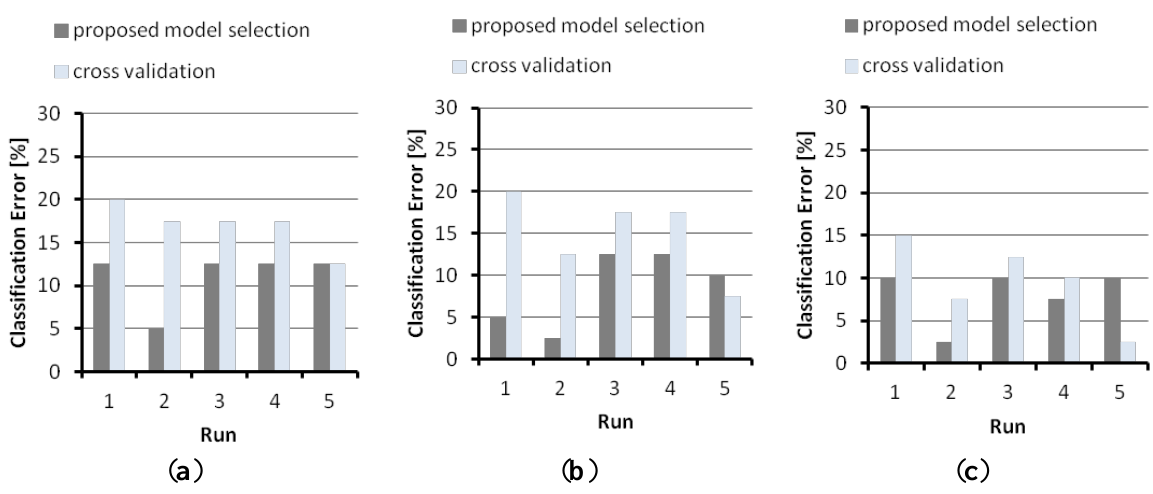
Figure 7. A comparison between the generalization performance obtained by applying the model selection of Algorithm 1 and conventional cross-validation. The graphs refer to